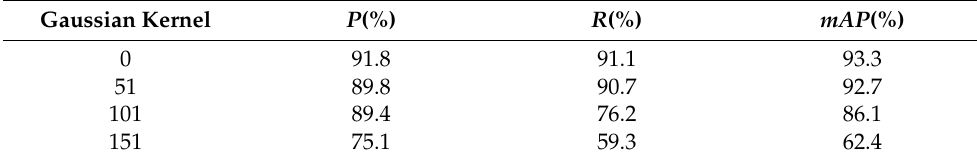
Table 9. The detection results of RDE-YOLOv7 under different blur conditions.